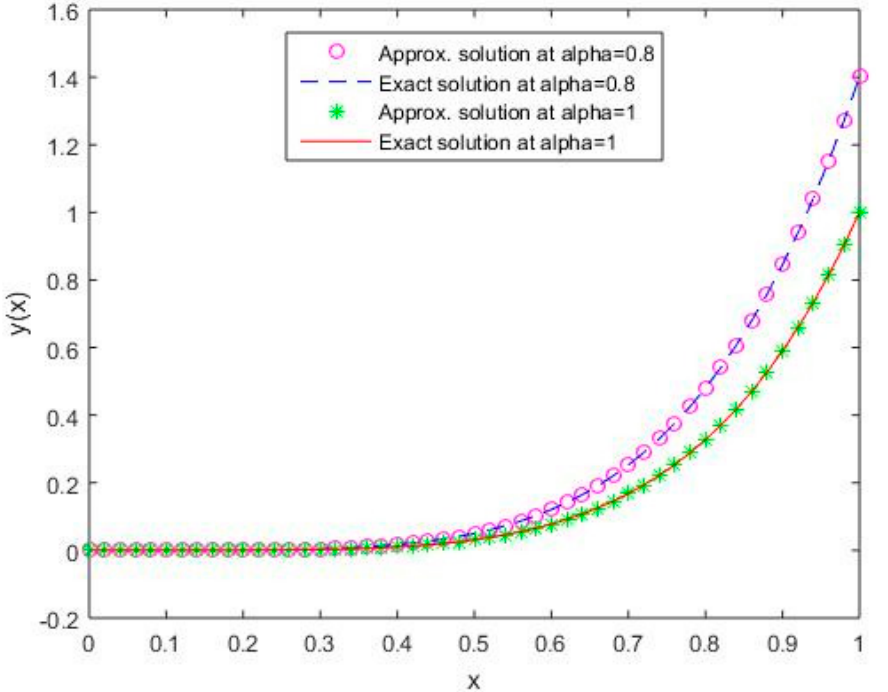
Figure 4. Comparison of exact and numerical solutions using S4 for α = 0.8 and α = 1, Example 1.